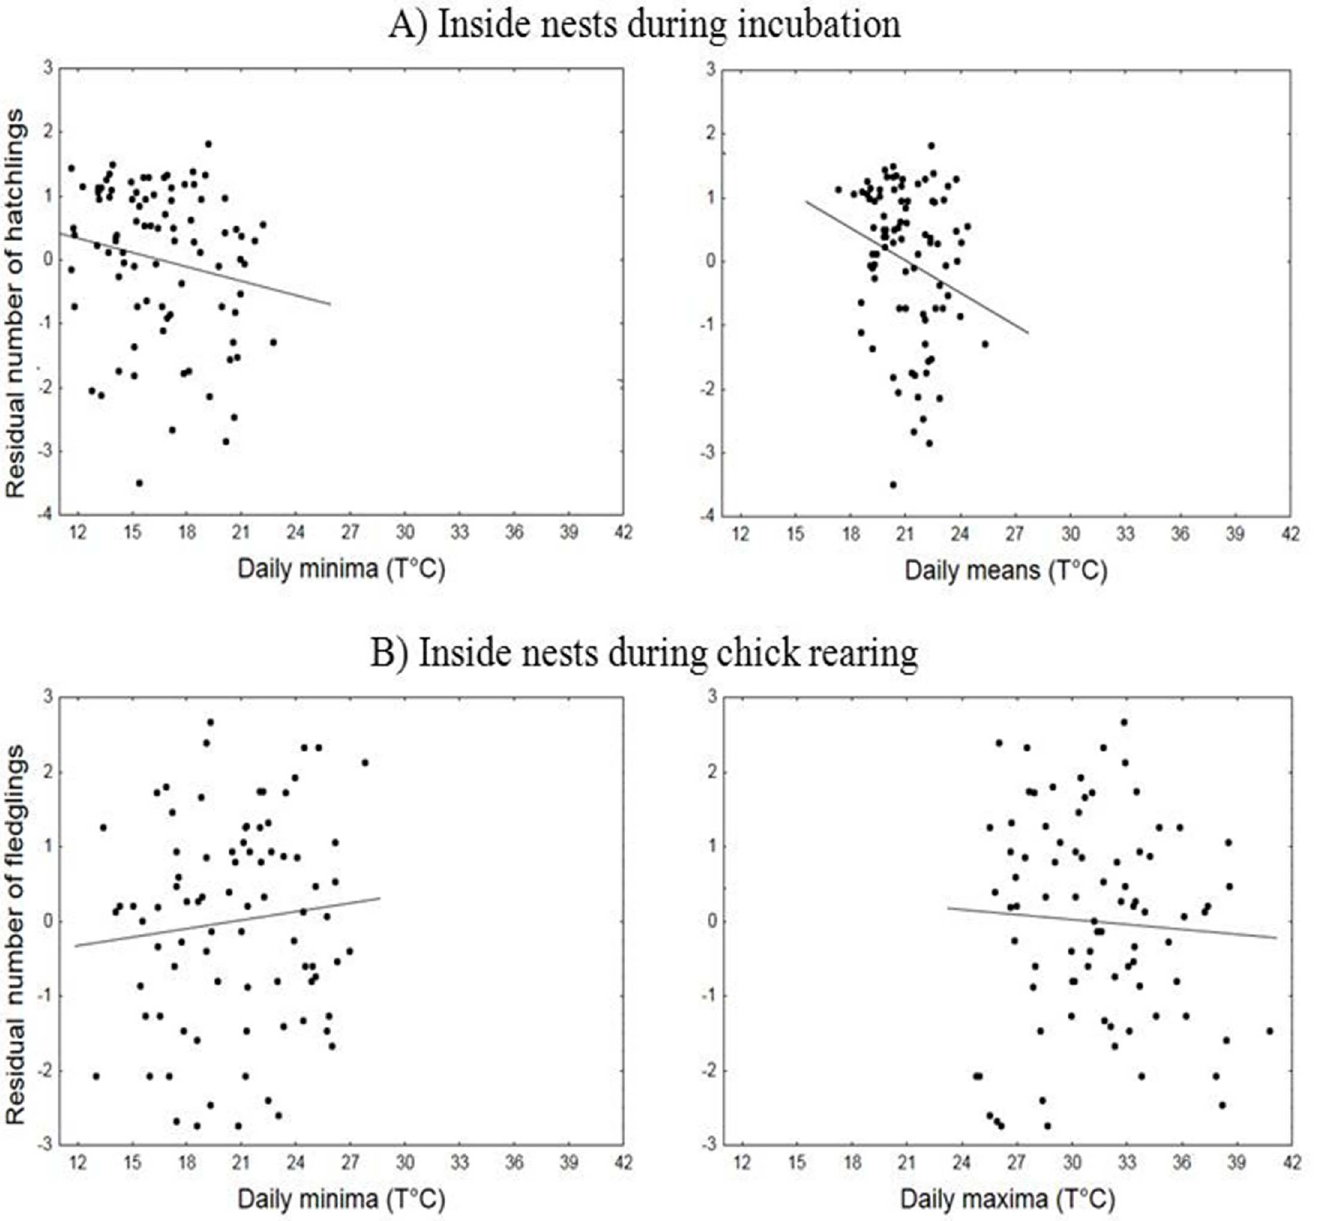
Fig 3. Residuals not explained by first laying day and clutch size of the number of hatchlings (A) and fledglings (B) in 90 and 84 nests, respectively, of lesser kestrels as functions of daily temperatures. Despite being the only predictor includedin the best models, nest microclimate showedmeaningless estimates indicatingits not significanteffect on nesting outcome. Lines show linear